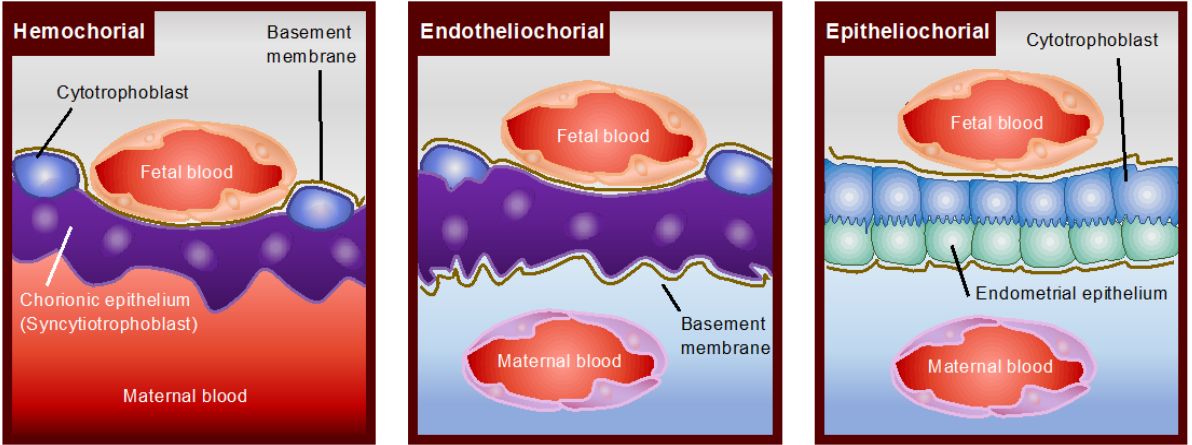
Figure 2. Placental classification according to separation between fetal and maternal blood supplies. There are three layers of separate maternal and fetal blood in Hemochorial (primates and rodents); chorionic epithelium (syncytiotrophoblast), chorionic interstitium (basement membrane), and chori- onic capillaries (fetal blood). In Endotheliochorial (dogs and cats), there are five layers between the maternal and fetal blood; endometrial capillaries (maternal blood), endometrial interstitium, chori- onic epithelium, chorionic interstitium and chorionic capillaries. In Epitheliochorial (pigs and horses), six layers separate the maternal and fetal blood; endometrial capillaries, endometrial interstitium, endometrial epithelium, chorionic epithelium, chorionic interstitium, and chorionic capillaries. It should be noted that hyenas belong to the order carnivore, but the hyena undergoes hemochorial placentation (Figure 3). A hemochorial placentation is seen in higher primates, including humans and many rodents—the latter in which the inverted yolk sac co-exists. In this type of placentation, maternal blood is directly in touch with the trophectoderm cells and is thus unlike other types of placentation. The capillary endothelium does not exist at or near the region where metabolic exchange